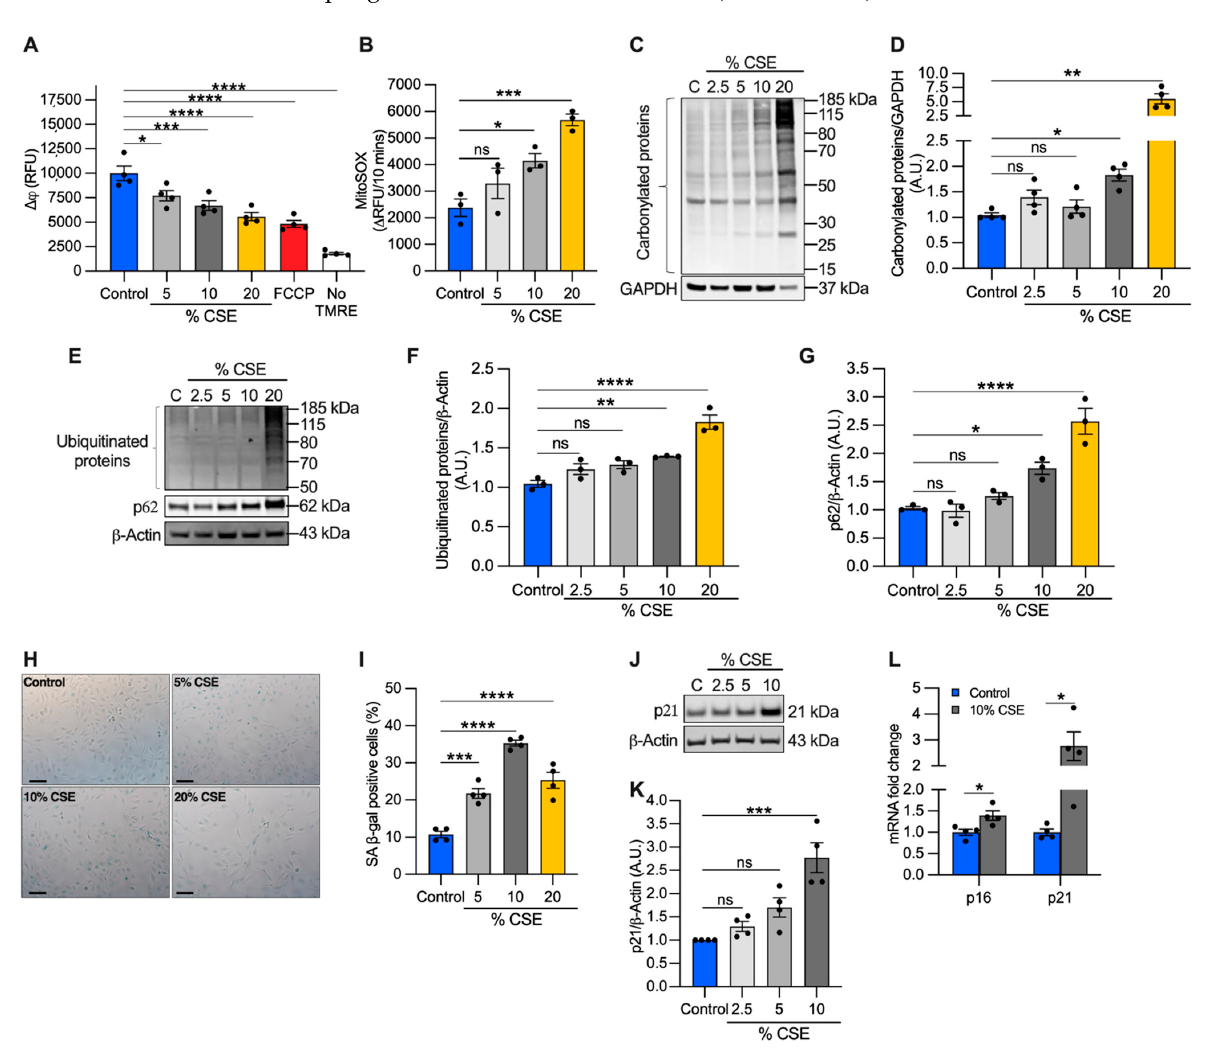
Figure 4. CSE affects mitochondrial membrane potential ( ∆ ψ ), promotes oxidative stress, and induces replicative senescence. ( A ) Bar graph reporting the ∆ ψ as relative fluorescence unit of BEAS-2B cells exposed for 6 h to CSE and incubated for 20 min with 250 nM tetramethylrhodamine ethyl ester (TMRE). Cells incubated without TMRE or with 20 µ M carbonyl cyanide p-trifluoro-methoxyphenyl hydrazone (FCCP) were used as negative and positive controls, respectively; ( B ) bar graph reporting the superoxide anion production as the variation of the relative fluorescence unit (RFU) of MitoSOX over 10 min in BEAS-2B cells exposed for 3 h to CSE. Representative Western blots showing total ( C ) carbonylated and ( E ) ubiquitinated proteins, ( E ) p62 and ( J ) p21 proteins in BEAS-2B cells exposed for 24 h to CSE. GAPDH or β -actin proteins were used as a loading control. Bar graphs report the densitometry of total ( D ) carbonylated and ( F ) ubiquitinated proteins, and ( G ) p62 and ( K ) p21 proteins; ( H ) representative micrograph images and ( I ) quantification (percentage of total cells) of senescent-associated β -galactosidase positive cells after 24 h of exposure to CSE. Scale bar = 100 µ m; ( L ) bar graph reporting the gene expression of p16 and p21 in cells exposed for 24 h to a sublethal dose (10%) of CSE as compared with the control. ( A , B , D , F , G , I , K , L ) Data are shown as mean ± SEM of independent experiments ( n ≥ 3) indicated as circles. CSE, cigarette smoke extract; control, CSE- unexposed cells; ns, no statistical significance; * p < 0.05, ** p < 0.01, *** p < 0.001, **** p < 0.0001, ( A , B , D , F , G , I ) by one-way ANOVA analysis as compared with the control with Bonferroni post hoc test, or ( K ) Kruskal–Wallis post hoc tests, and ( L ) unpaired t -test with Mann–Whitney